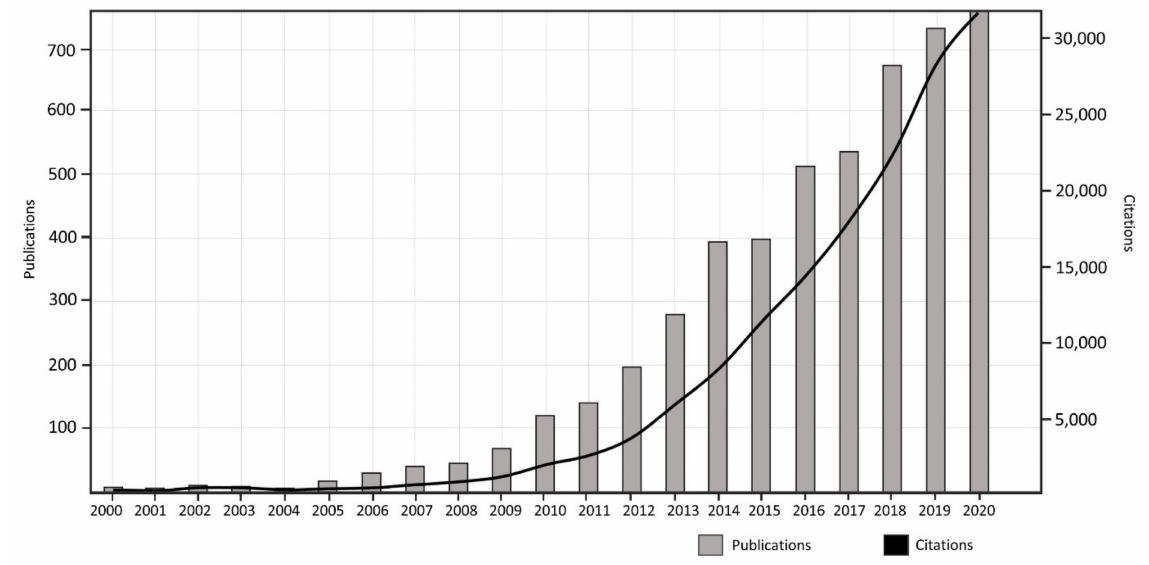
Figure 1. Number publications and citations related to ecosystem services research in Web of Science Core Collection (WoSCC) database from 2000 to